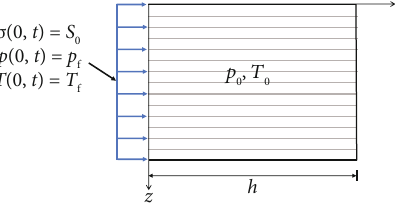
Figure 4: One-dimensional consolidation setup showing the initial and top boundary conditions, where the plane ( xy ) is the isotropic plane, where the x axis has a subscript of 1, and the z axis is the axis of rotational symmetry with a subscript of 3. The top, bottom, and right boundaries (in bold) are assumed impermeable, adiabatic, and